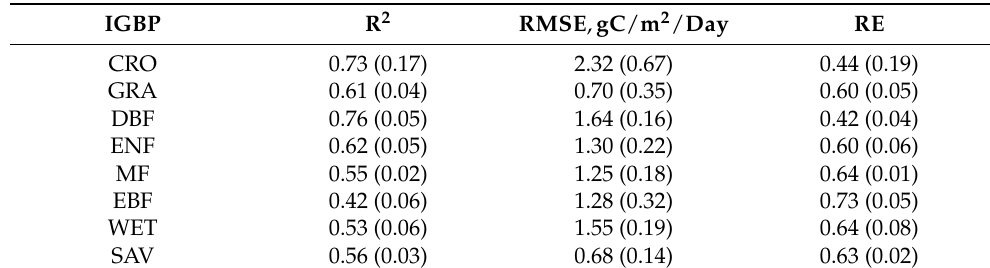
Table 4. Cross-validation metrics (and standard deviation of the residuals for each metric) for daily NEE models per land-cover